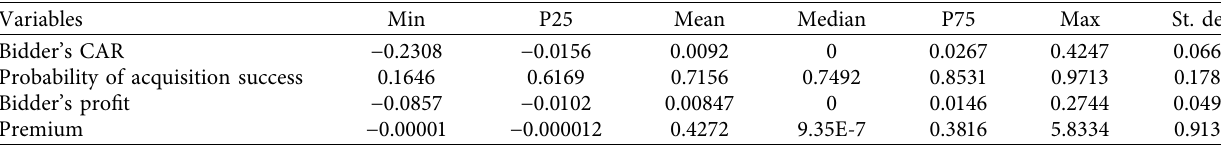
Table 5: Summary statistics.